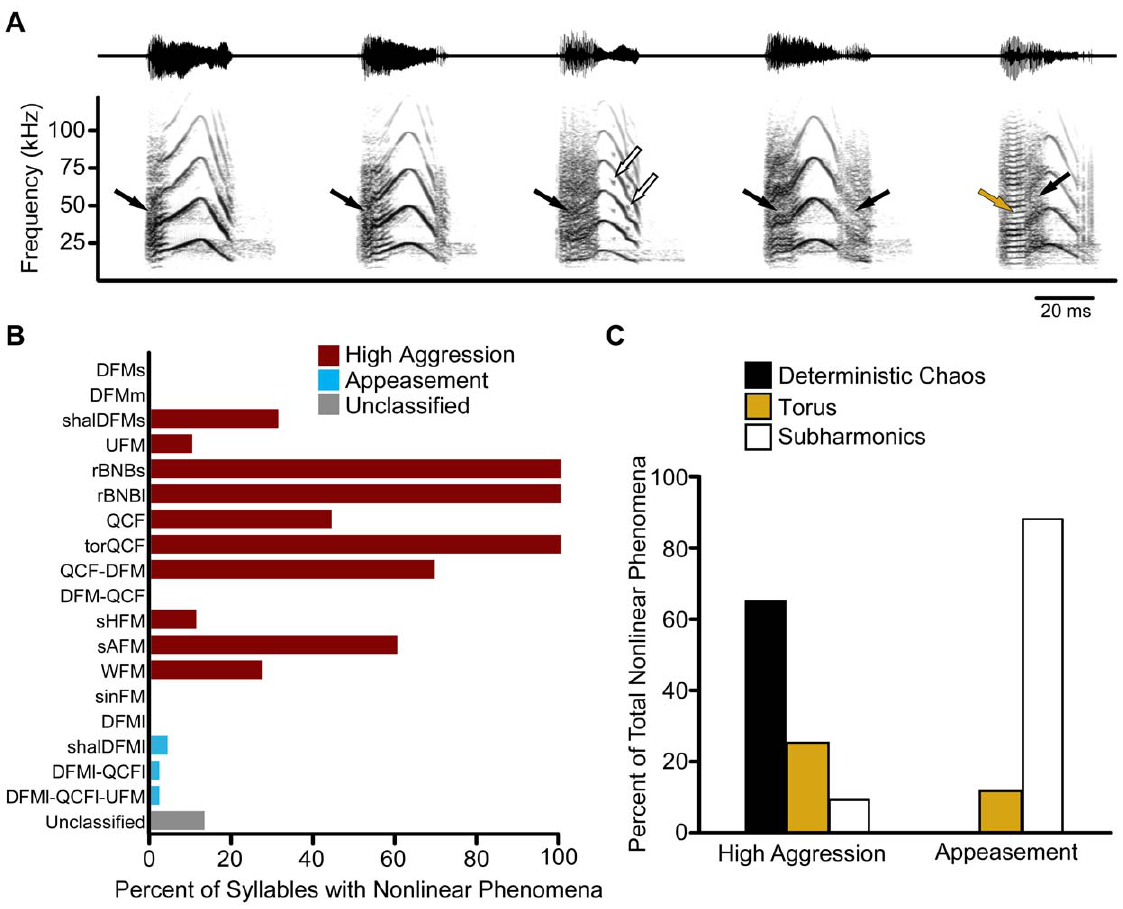
Figure 7. Nonlinear phenomena are differentially observed across syllable type and behavioral context. ( A ) Example waveforms ( upper trace ) and spectrograms ( lower trace ) of sAFM syllables emitted from the same bat. Syllables contain varying degree and type of nonlinearities, such as deterministic chaos ( black arrow ), subharmonics ( open arrow ), and torus ( gold arrow ). ( B ) Nonlinear phenomena were more commonly observed in high aggression syllable types. ( C ) Deterministic chaos was the most common nonlinear phenomenon in high aggression syllables. Although less common overall, nonlinearities observed within appeasement syllables were more likely to be of the subharmonic type.